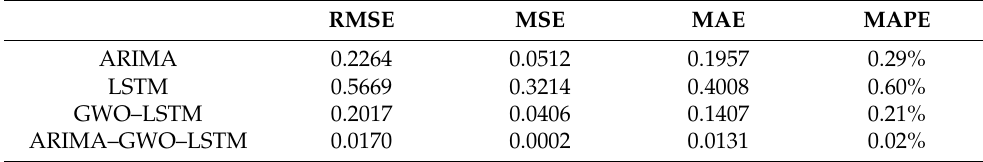
Figure 10. ARIMA modeling results. Table 2. HKCL high-frequency component model prediction accuracy evaluation table.